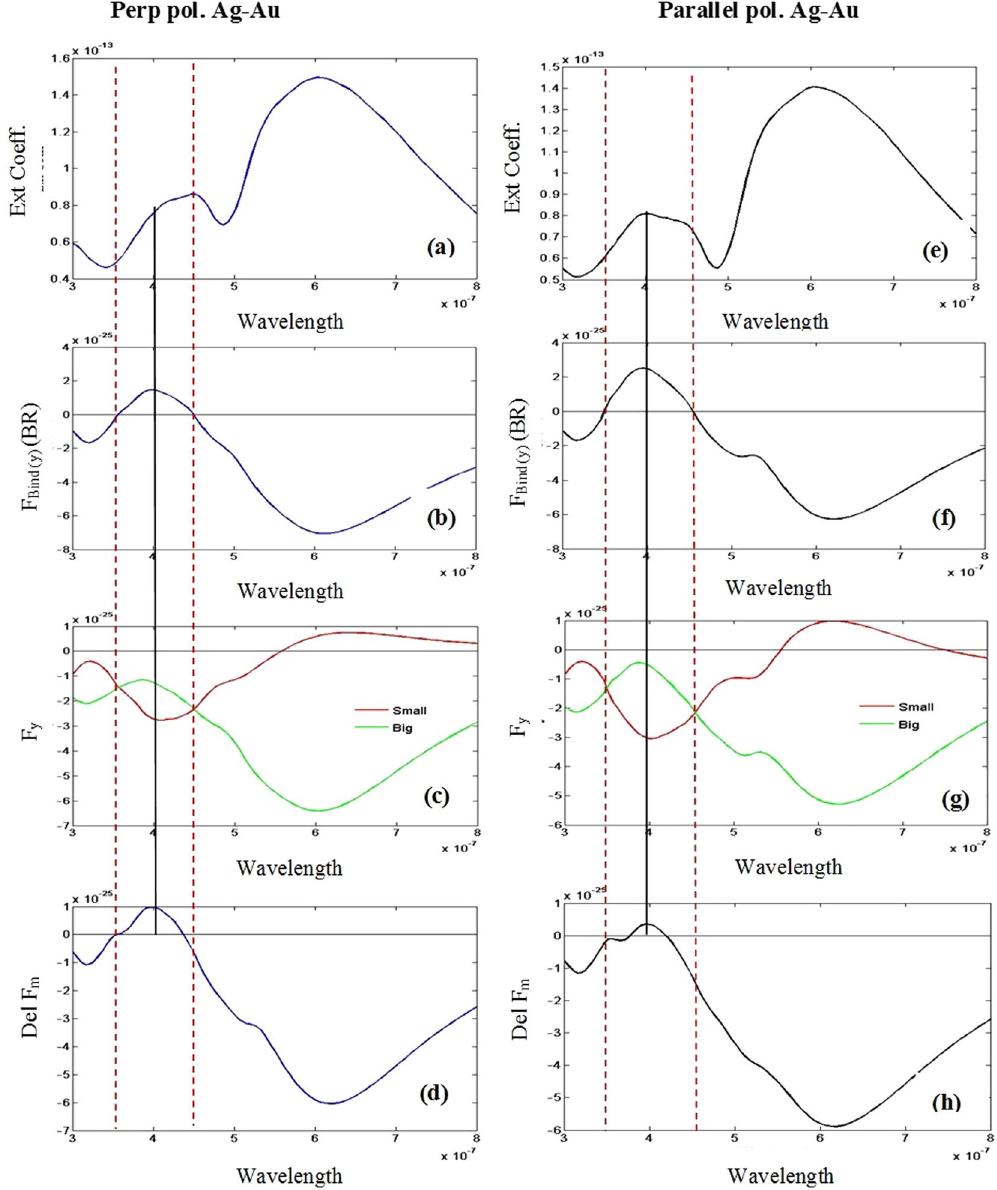
Figure 5. SR and BR represent ‘small rotate’ and ‘big rotate’ respectively. All wavelengths are in meter (m) unit. All Forces are in Newton (N) unit. For off axis Ag-Au and BR [the configuration of Fig. 1(d) and ‘ ȹ ’ = 70 degree]: Considering perpendicular polarized light ( a ) Extinction co-efficient ( b ) The longitudinal binding force F Bind(y) (BR) ( c ) Time averaged force on each particle. ( d ) Difference of bulk Lorentz force. Considering parallel polarized light for same configuration ( e ) Extinction co-efficient ( f ) The longitudinal binding force F Bind(y) (BR) ( g ) Time averaged force on each particle. ( h ) Difference of bulk Lorentz